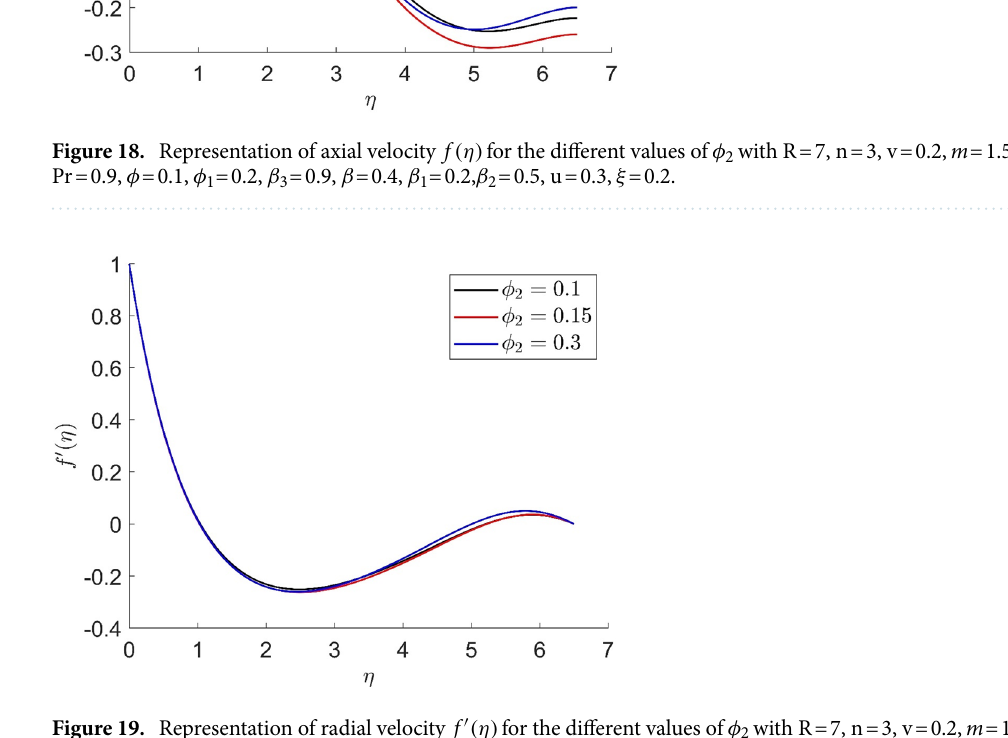
Figure 19. Representation of radial velocity f ′ (η) for the different values of φ 2 with R = 7, n = 3, v = 0.2, m = 1.5, Pr = 0.9, φ = 0.1, φ 1 = 0.2, β 3 = 0.9, β = 0.4, β 1 = 0.2, β 2 = 0.5, u = 0.3, ξ =